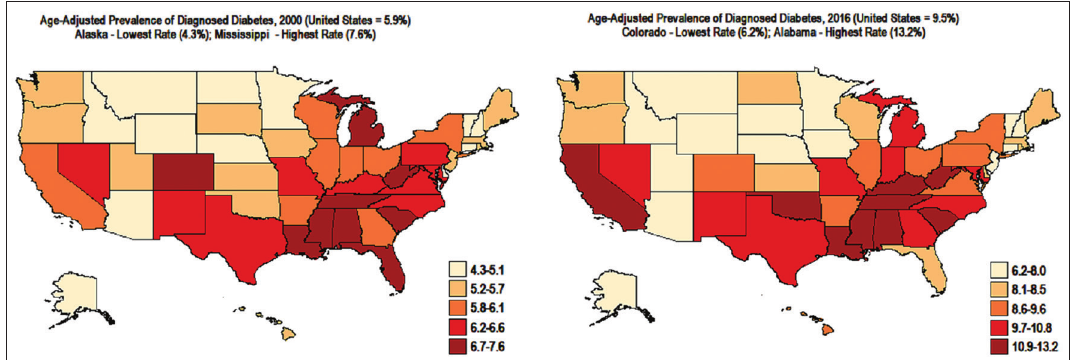
Fig ure 26. Age-adjusted Prevalence of Diagnosed Diabetes among Adults Aged ≥18 years, by State, United States, 2000 and